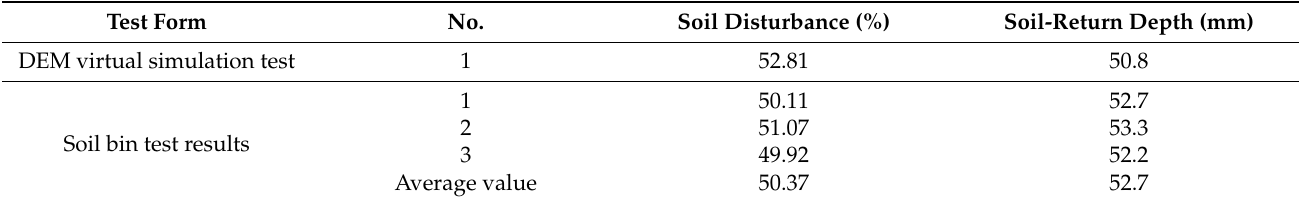
Table 3. Comparison of DEM virtual simulation test and soil bin test results.